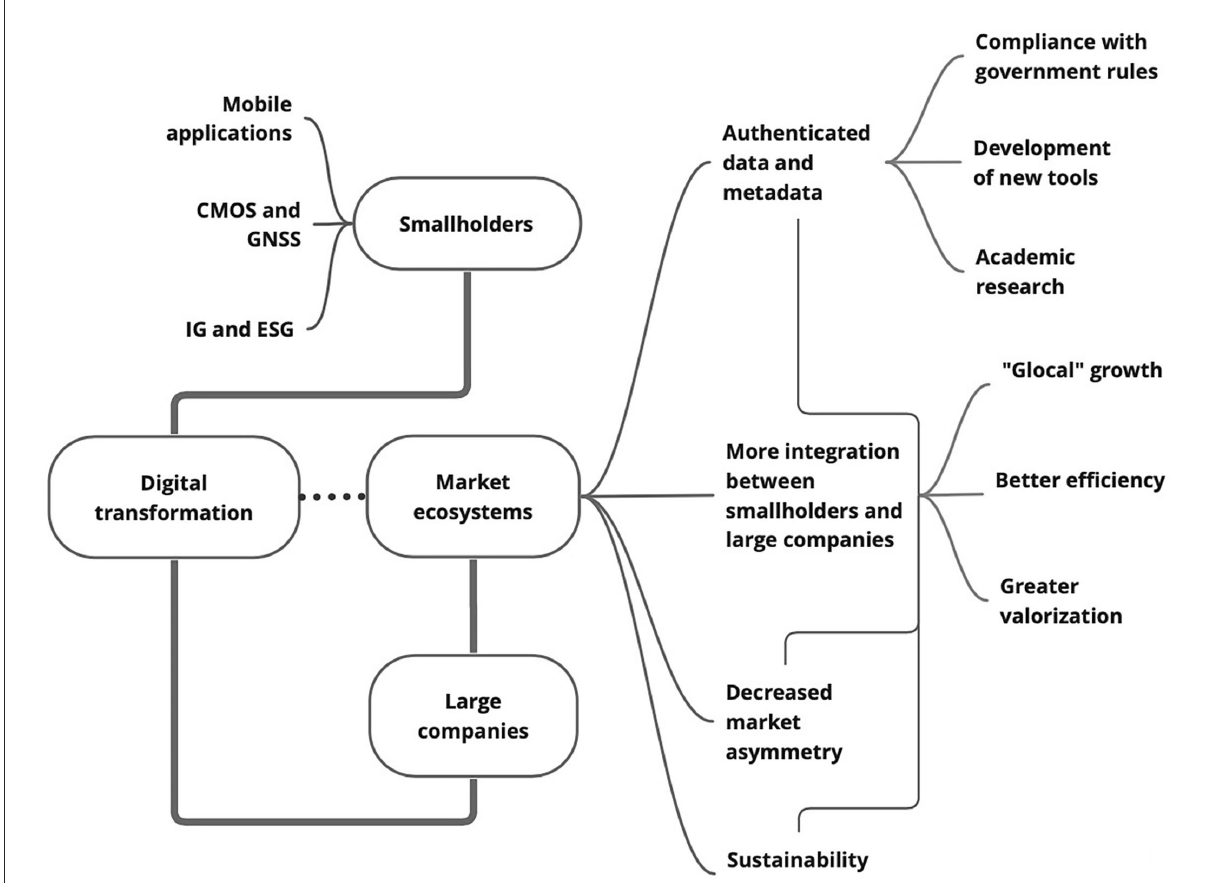
FIGURE3 Mental map of smallholders access to the market ecosystem with digital